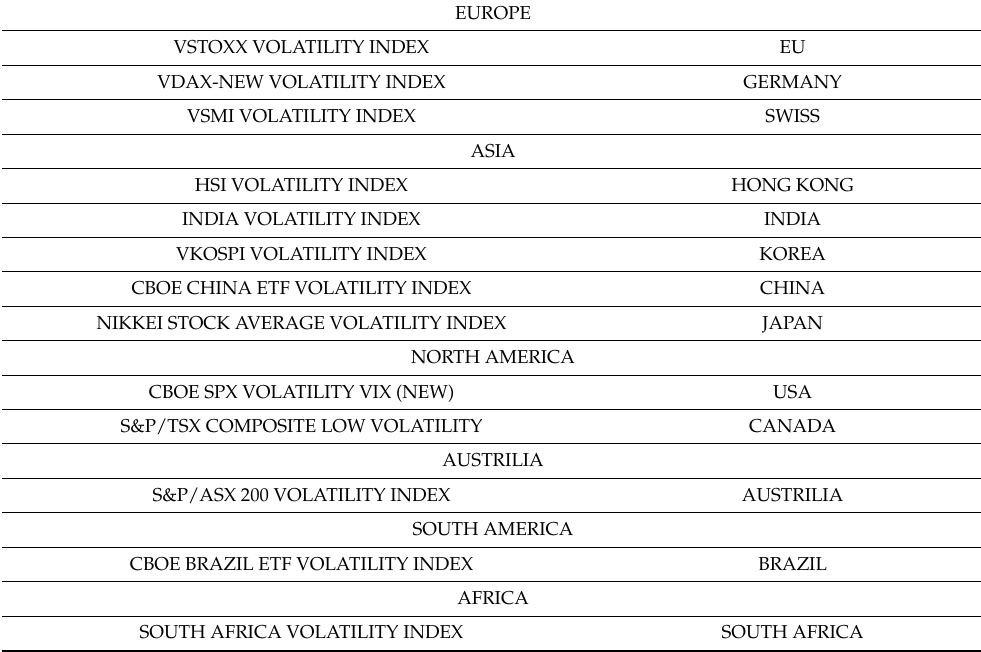
Table A3. Acronyms of each implied volatility